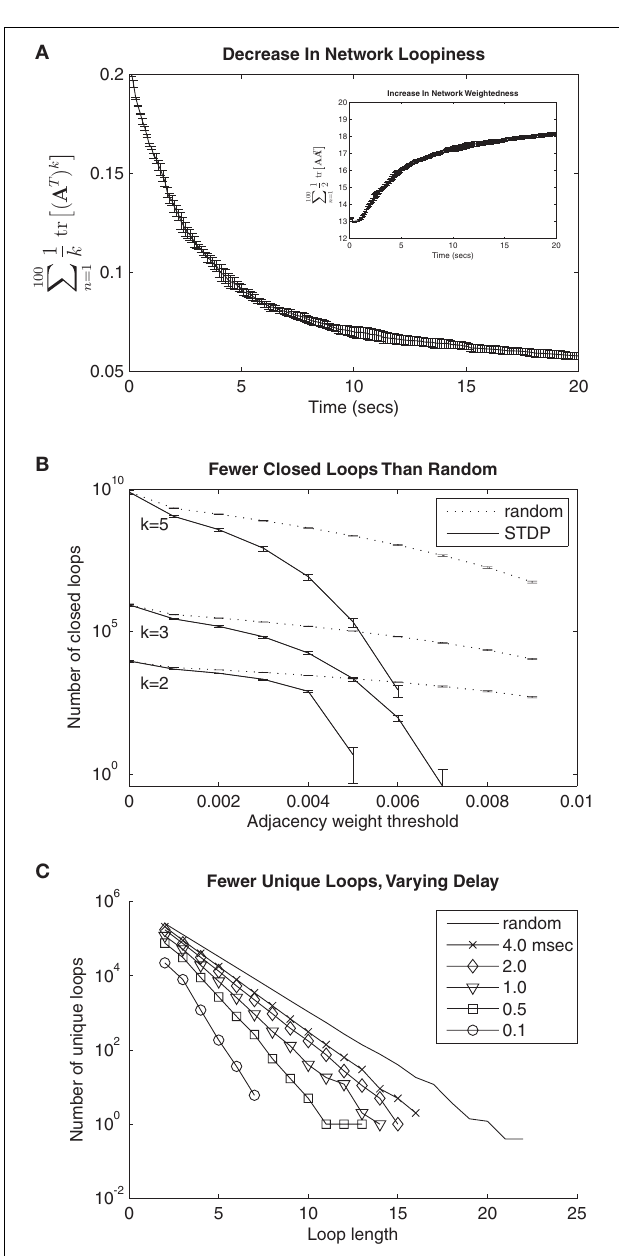
FIGURE 2 | Global topological effects of STDP. (A) A monotonic decrease in the loopiness measure (see Eq. 2, fi rst term) over time is observed in a simulated network of 100 neurons undergoing STDP. Simultaneously, STDP results in a net increase in the weightedness of the network (inset, see Eq. 2, second term). Shown here and in (B) is the average of eight separate simulations of 20 s of network activity; error bars are standard deviation. (B) Number of closed loops of length 5, 3, and 2, decreases as a function of weight threshold for network connections. Dotted lines show counts for randomized networks with same number of total connections. (C) Number of unique loops sampled from fi ve networks with varying synaptic delays following 10 s of simulated activity, and from a random network with 5000 connections. Number of loops is shown as a function of loop length. Loops were sampled across different learned networks while maintaining the number of network connections at 5000 by varying the weight threshold (from 0.003 to 0.0046) for each delay. Greater synaptic delays decreases the loop-eliminating topological effect of standard